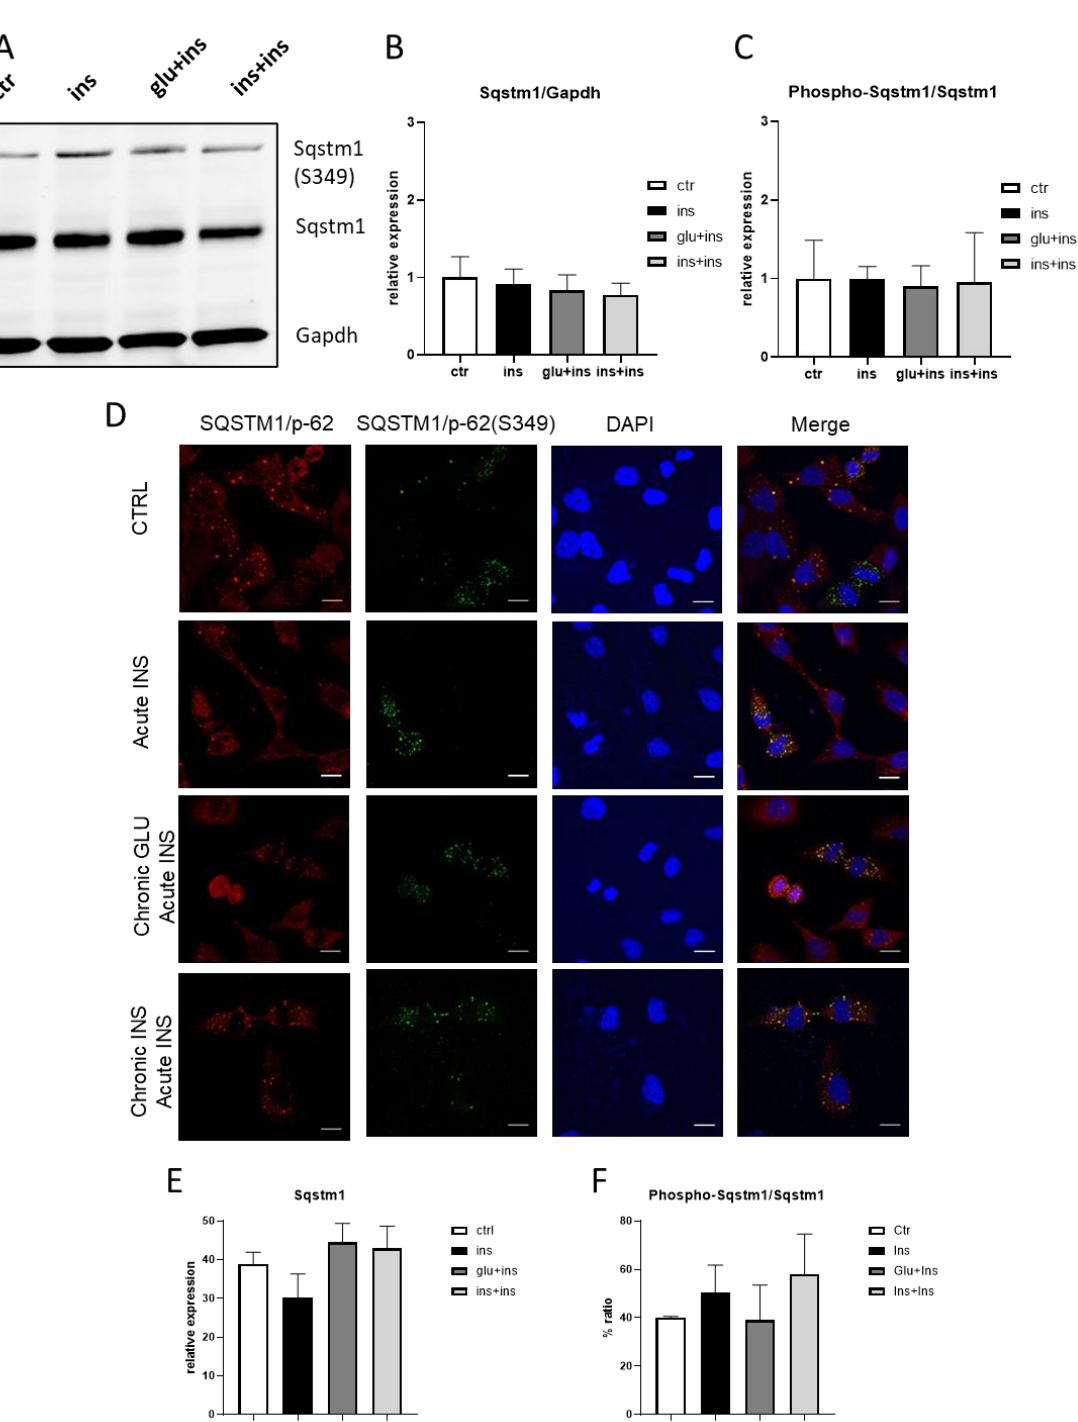
Figure 5. Phospho-Sqstm1 and Sqstm1 protein levels after insulin challenge (ins: 100 nM 30 min) or chronic glucose (glu + ins: 24 h 40 mM followed by 100 nM insulin 30 min) or chronic insulin (ins + ins: 24 h 20 nM insulin followed by 100 nM insulin 30 min) or vehicle (ctr) measured by Western blotting ( A – C ) or immunofluorescence ( D – F ). ( A ): sample immunoblot; ( B ): Sqstm1 levels; ( C ): phospho-Sqstm1/Sqstm1 ratio; ( D ) Sqstm1 immunofluorescence; ( E ): Sqstm1 dots/cell; ( F ): phospho-Sqstm1/Sqstm1 ratio (Scale bar: 15 µm). The means + SEM are plotted; n = 3 – 4.